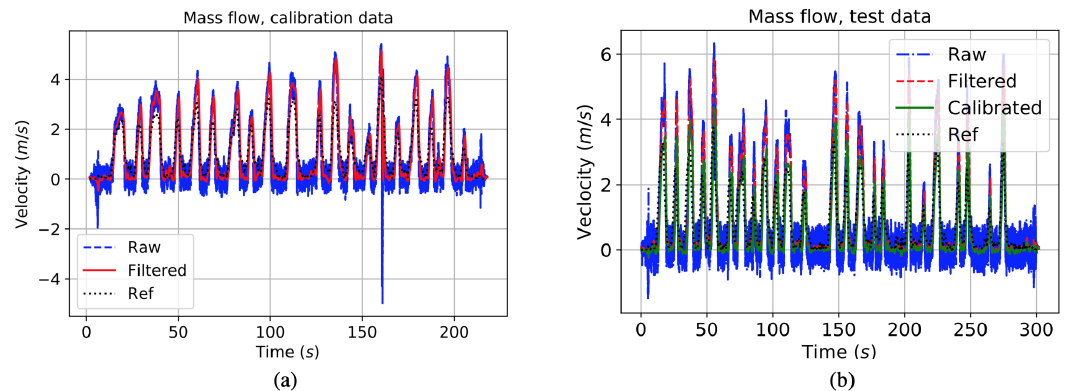
Figure 4. ( a ) Raw, filtered, and calibrated mass flow training and ( b ) testing data.